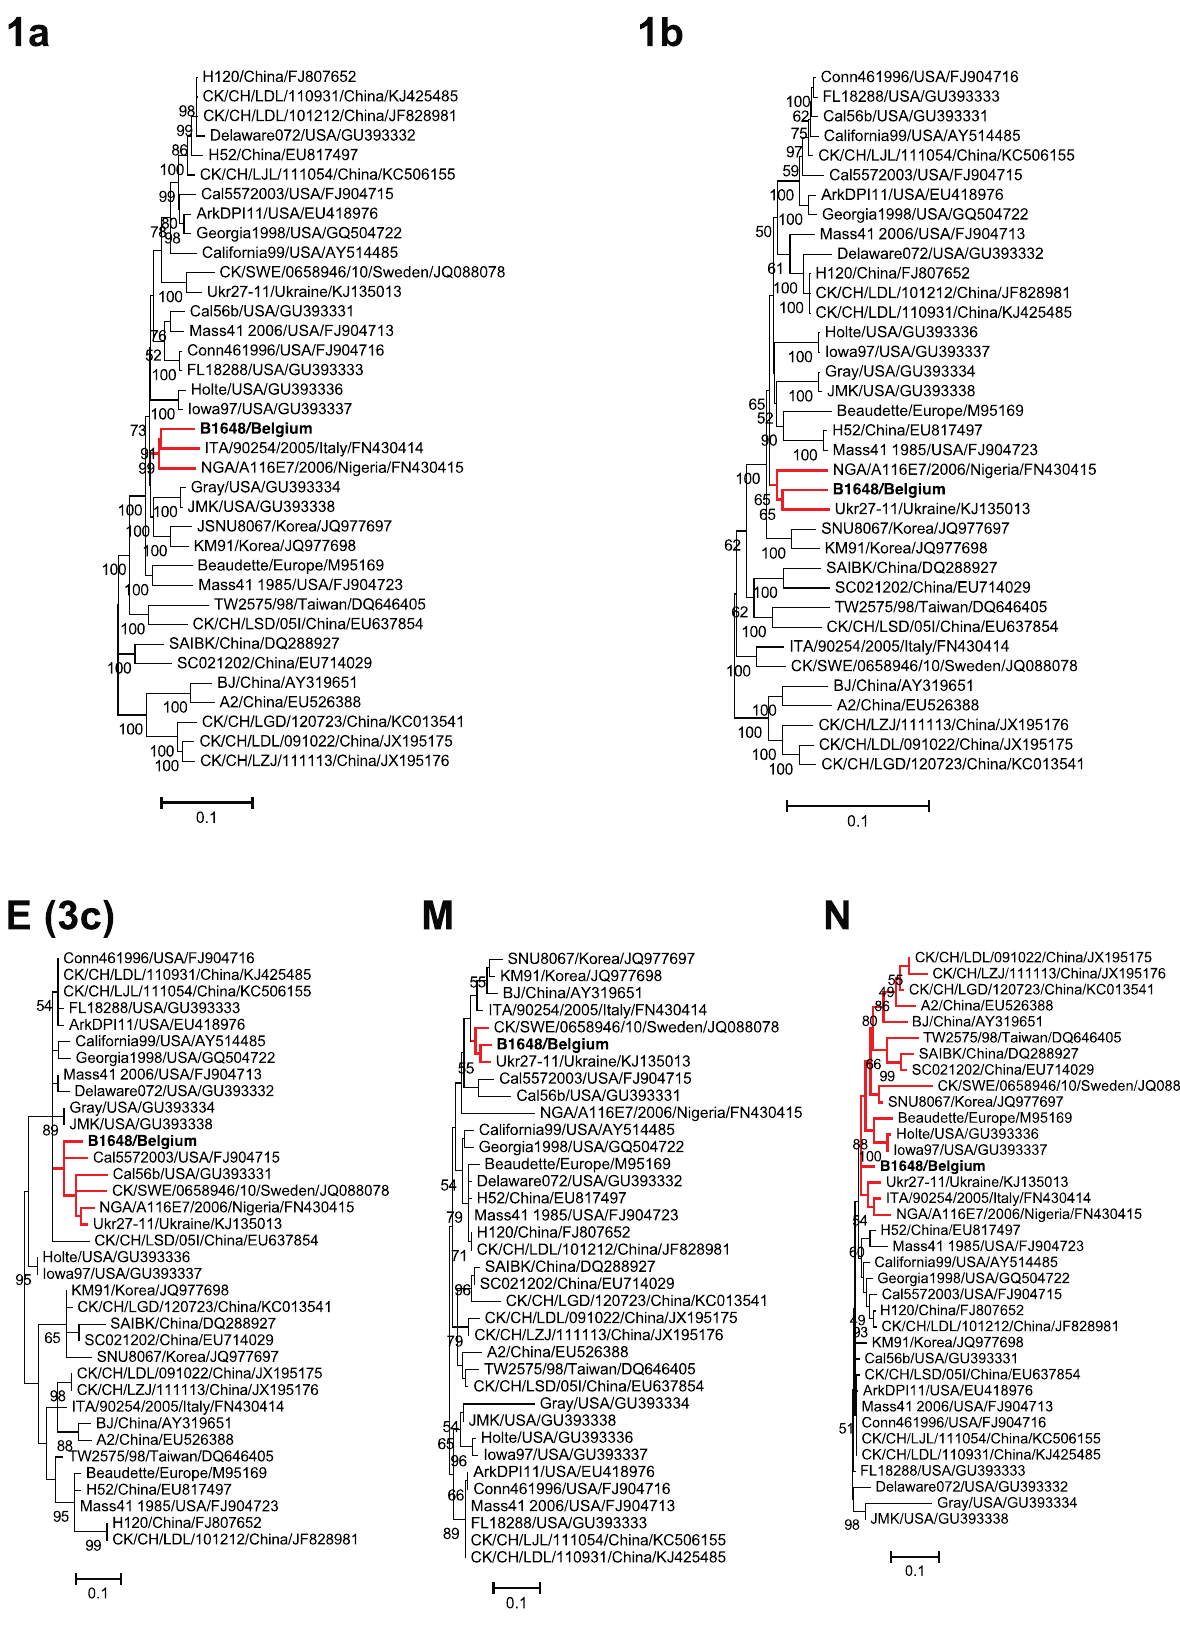
Figure 3. Maximum likelihood phylogenetic trees based on amino acid sequences of 1a, 1b, E (3c), M and N proteins. Bootstrap values ( n = 500 replicates) of <50% are not shown. Strain B1648 cluster is shown in red.